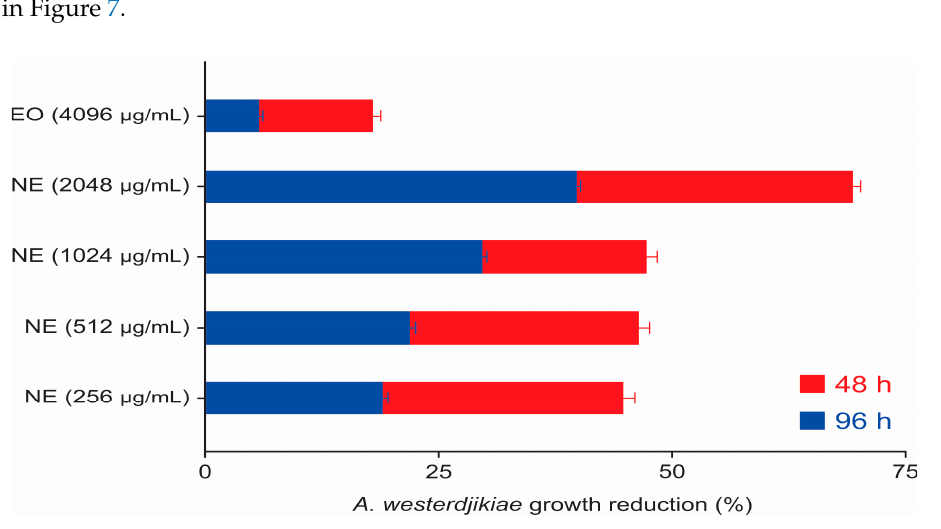
Figure 7. Inhibition of the A. westerdijikiae colonies by a concentration of EO and NE at 48 and 96 h.